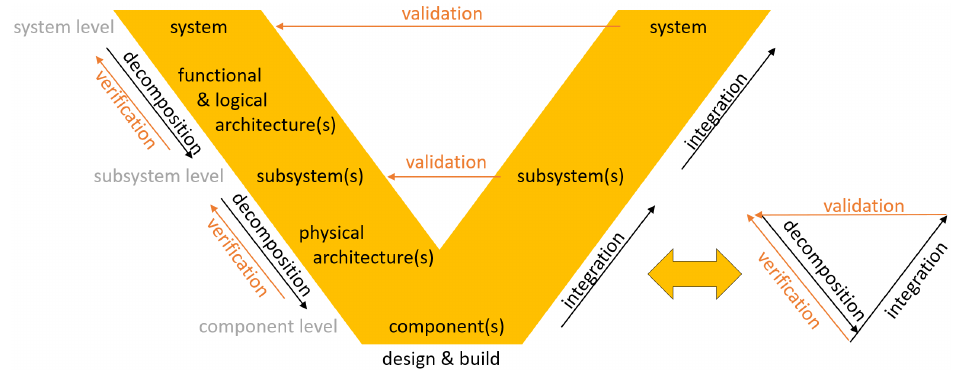
Figure 1. MBSE V-Model (left) including validation and verification pattern (right)